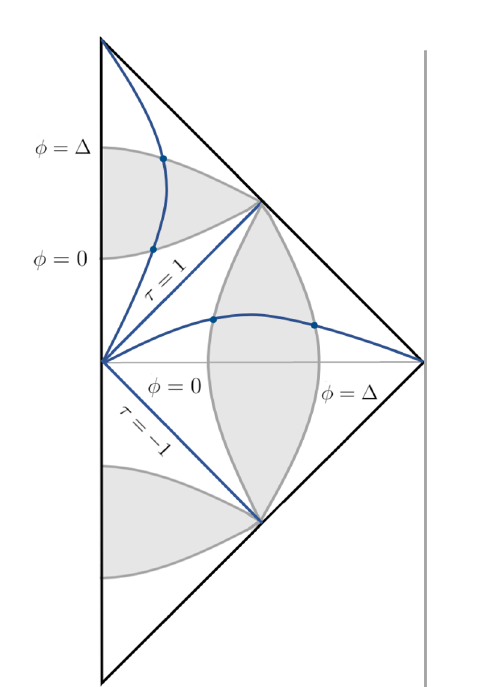
Figure 3. The fundamental regions for the lower and upper patches in ( τ, φ ) coordinates, both shaded in gray. The blue dots correspond to identified points. Lower patch : determined by τ 2 < 1 , φ ∈ [0 , ∆] . Blue line is constant τ < 1 spatial slice. Upper patch : described with τ > 1 , and with φ ∈ [0 , ∆] now as compact time coordinate. Blue line indicates constant τ > 1 timelike trajectory. The chronological horizons are reached for τ = ± 1